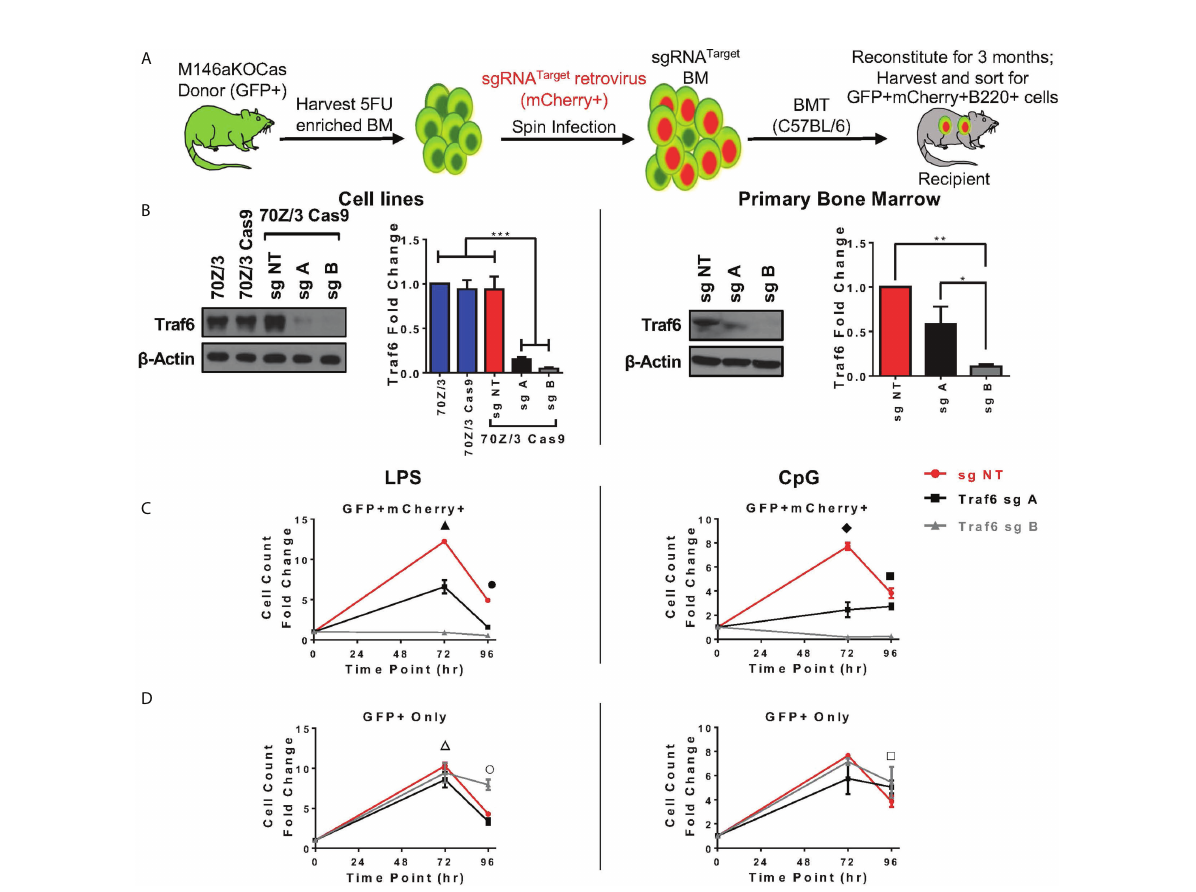
FIGURE 5 In vivo Traf6 r eduction results in graded decrease of miR-146a mediated B-cell response. (A) Schema of BMT for Traf6 guides. (B) TRAF6 expression via Western Blot. Left panel: validation of TRAF6 deletion in 70Z/3 Cas9 cells. Repeated in duplicate. Right panel: Sorted reconstituted recipient GFP+ mCherry+ bone marrow cells show TRAF6 deletion levels. Data represent three independent experiments. One-way ANOVA with Tukey ’ s multiple- comparisons test; * P < 0.05, ** P < 0.01, *** P < 0.001. (C, D) Splenic B-cells from BMT recipients are stimulated ex vivo with LPS (left) or CpG (right). (C) M146aKOCas donor cells (GFP+) with sg transduced (mCherry+) cells show NT control (red) with high cellular response (similar to native miR-146aKO stimulations in Figures 2C, D), but with graded decreased response in cells with Traf6 deletion (black and gray). (D) M146aKOCas donor (GFP+) cells without sg RNA transduction look similar among groups (red, black, gray). All bone marrow recipient groups: n = 8 mice/group, total 24 mice/exp; repeated in two independent experiments. t test; * P < 0.05, ** P < 0.01, *** P < 0.001. All data represent mean ± SEM. M146aKOCas, MiR-146aKO-Cas9- eGFP mice; BMT, Bone Marrow Transplantation. ▲ : *** NT vs. A, **** NT vs. B, *** A vs. B; ● : **** NT vs. A, **** NT vs. B, *** A vs. B; ◆ : ***NT vs.